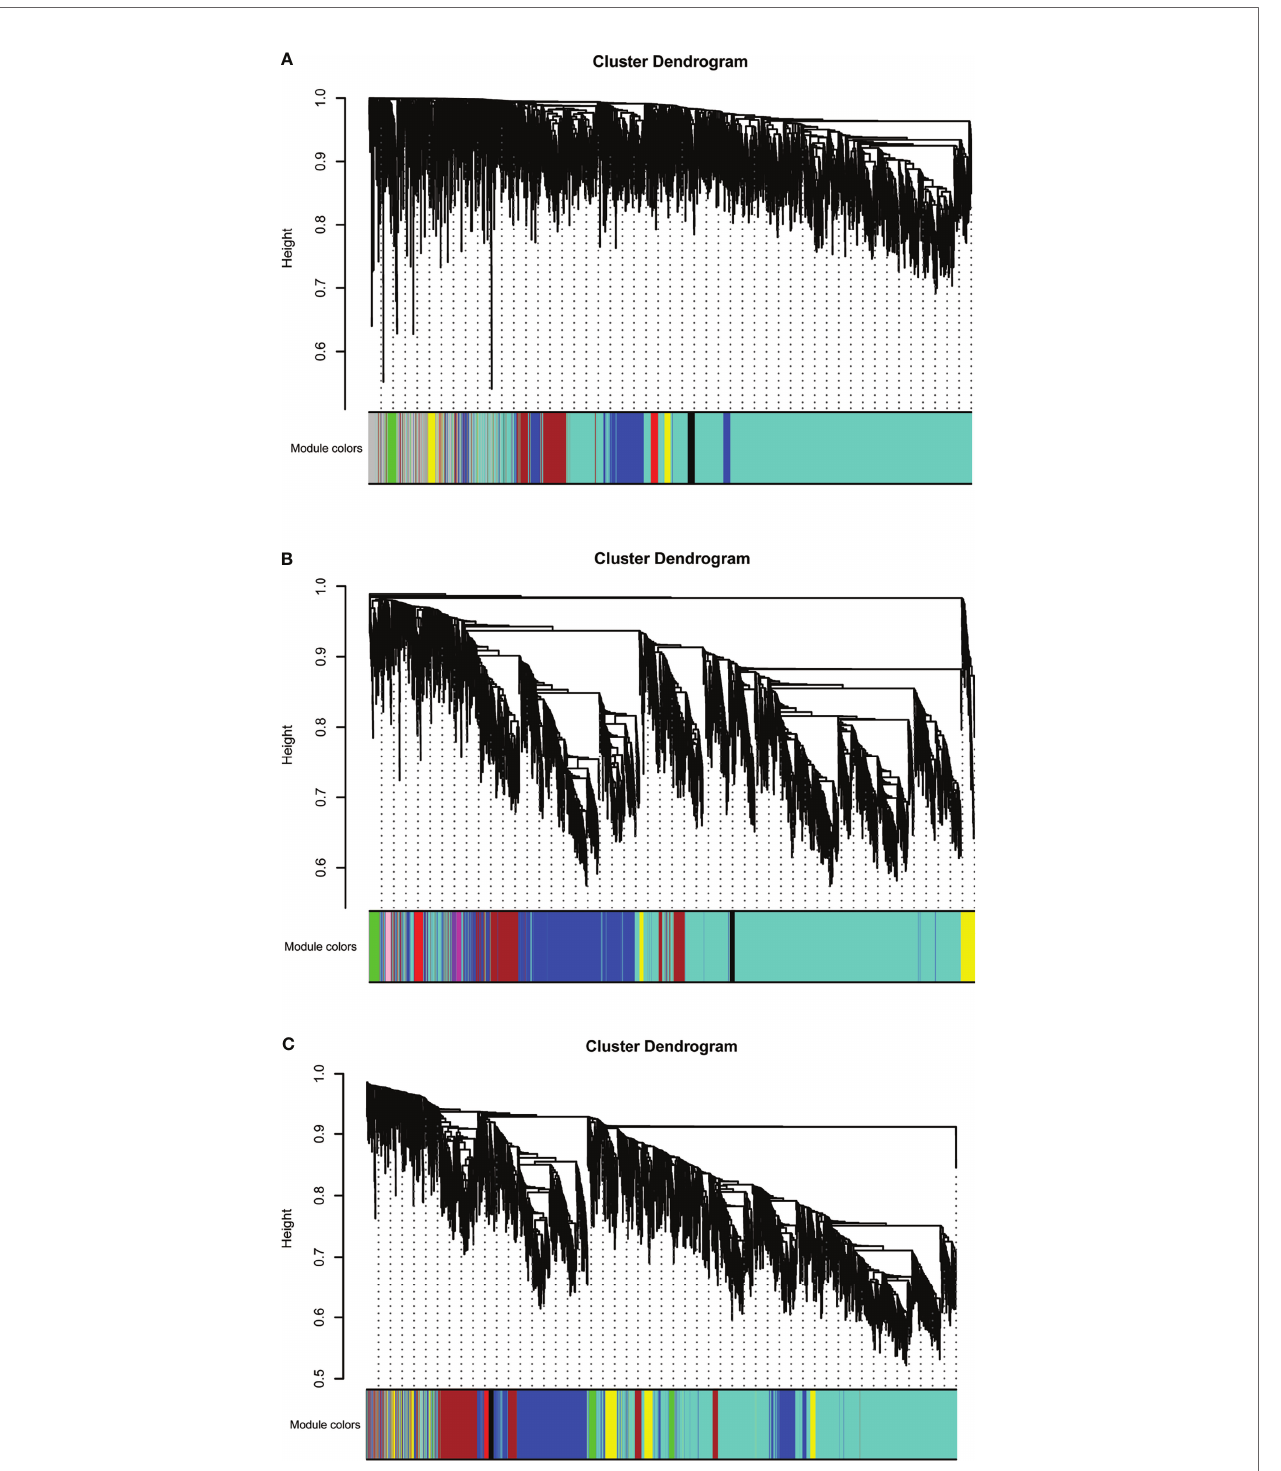
FIGURE 1 | Hierarchical clustering dendrograms of identi fi ed co-expressed genes in modules in (A) T2DM versus normal controls, (B) T2DM versus prediabetes and (C) prediabetes versus normal controls (different colors represent different